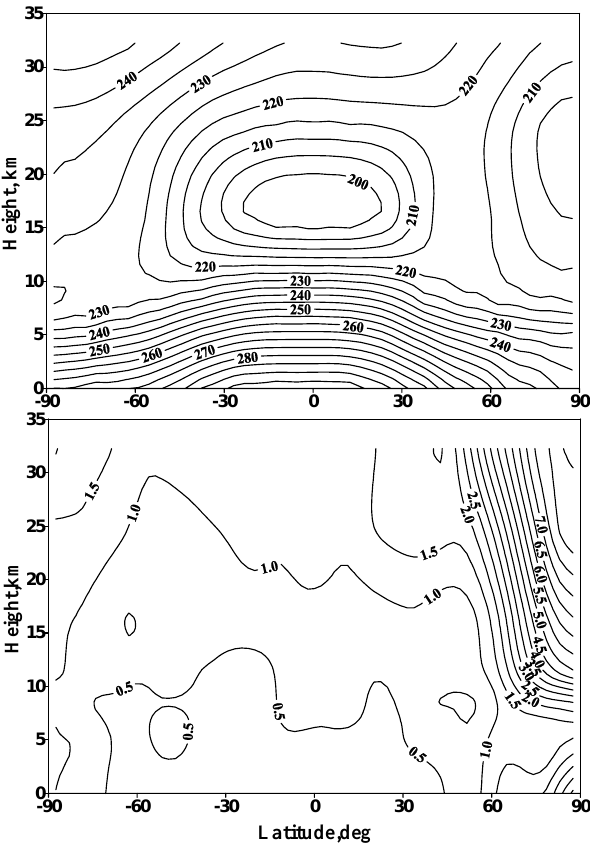
Fig. 3. Latitude-height sections of the zonally averaged temperature (upper panel) and their root-mean-square variability (lower panel) in January. Results obtained using 1981–1991 time